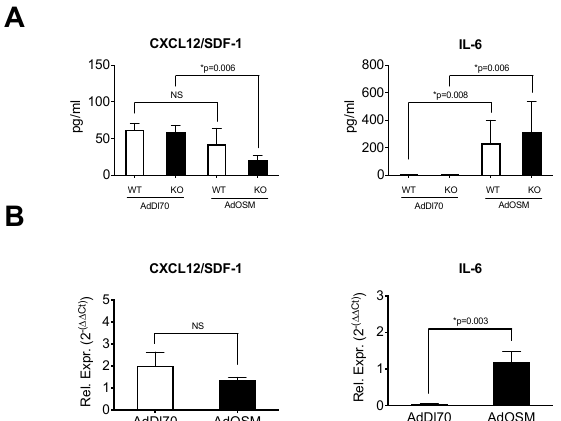
Figure 4. Regulation of fibrocyte chemokine mRNA by OSM. Wildtype BALB/c mice or IL-13-/- (KO) were treated with an endotracheal administration of AdDl70 or AdOSM (5 × 10 7 pfu) as indicated, culled, BALF retreived and lung tissues were isolated and prepared for RNA extraction. ( A ) CXCL12/SDF-1 and IL-6 proteins in BALF were analyzed by ELISA. ( B ) RNA was probed for CXCL12/SDF-1 and IL-6 using q-RT-PCR. Rel. Expr.: Relative expression (Relative to 18S RNA). Data is shown as the mean +/ − SEM ( n = 5 per group. Statistical significant differences are noted with their p values between the indicated treatment groups.